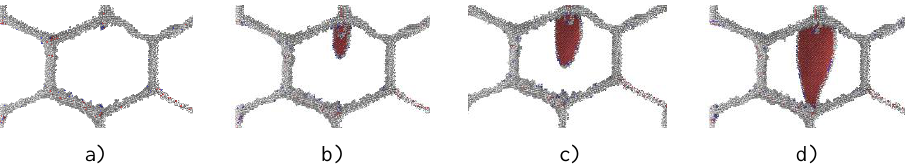
Fig. 2. Fragment of the structure with the stacking fault (highlighted in red) at different points in time: a) 75, b) 85, c) 86, d) 87 ps. The atoms belonging to the grains are not shown.